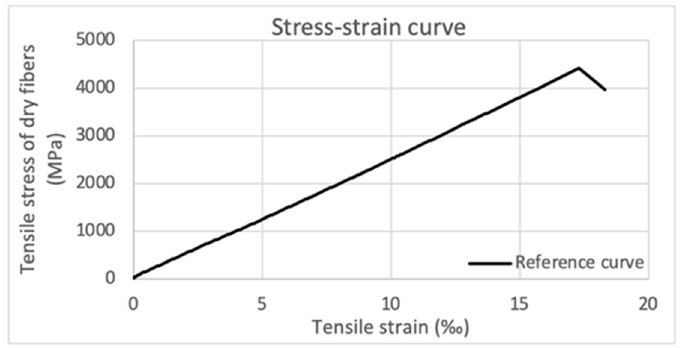
Figure 13. Stress–strain curve for monotonic, uniaxial tension at room temperature.